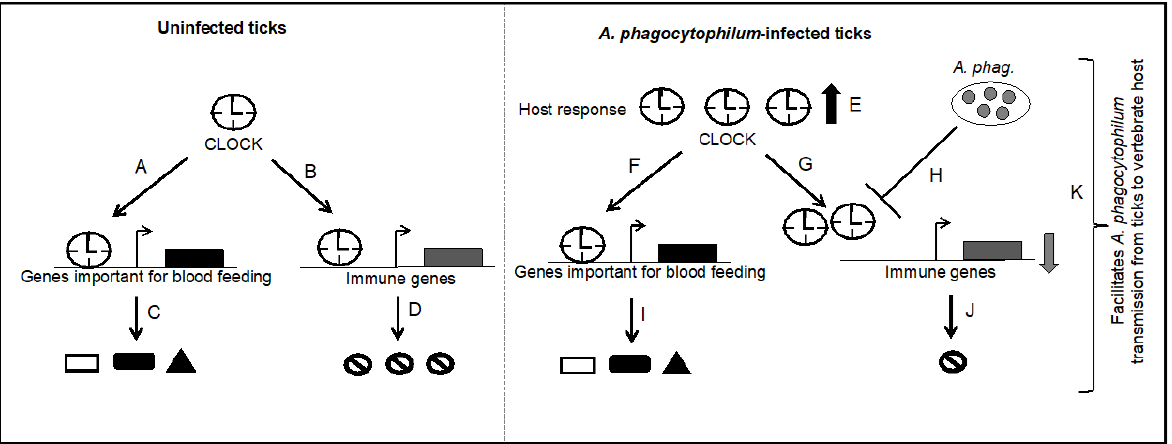
Figure 8. Model showing A. phagocytophilum ‐ associated modulation of arthropod circadian gene that facilitates bacterial transmission from ticks to the vertebrate host. In uninfected ticks, CLOCK facilitates transcription of genes critical for blood feeding ( A ); and immune responses ( B ).